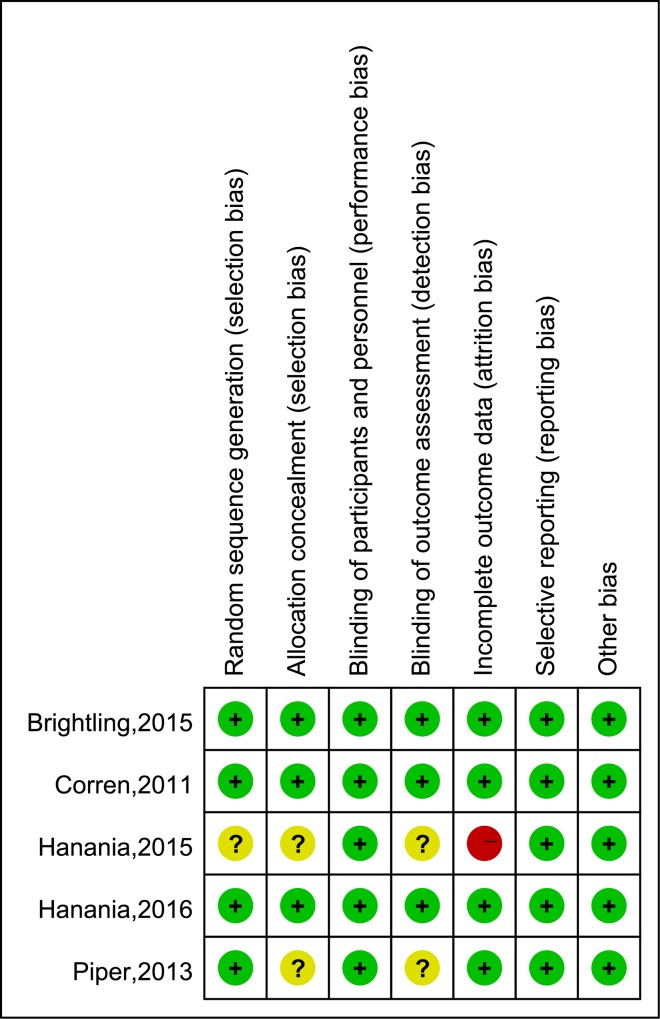
Risk of bias summary.